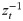
The generative model of VKF.The generative model consists of two interconnected hidden temporal chains, xt and zt, governing observed outcomes, ot. Arrows indicate the direction of influence. On each trial, t, outcome, ot, is generated based on a Gaussian distribution, its mean is given by the hidden random variable xt, and its variance is given by the constant parameter ω. This variable is itself generated according to another Gaussian distribution, which its mean is given by xt−1, and its variance is given by another hidden random variable, zt−1. This variable is itself generated based on its value on the previous trial, zt−1, multiplied by some positive noise distributed according to a scaled Beta distribution governed by the parameter λ. The inverse mean of this variable on the first trial is assumed to be given by another constant parameter, v0. See Eqs 1 and 6 for further explanation.